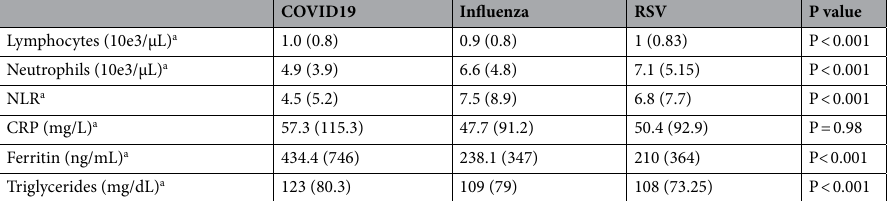
Table 2. Inflammatory markers of patients presenting with viral infections. a Continuous variables are presented as medians and inter-quartile ranges. COVID-19 coronavirus disease 2019, RSV respiratory syncytial virus, NLR neutrophil-to-lymphocyte ratio, CRP C-reactive protein.